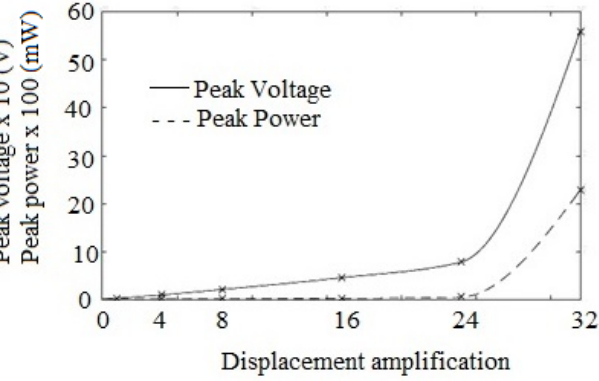
Figure 17. Variation of voltage and power with displacement amplification ratio.